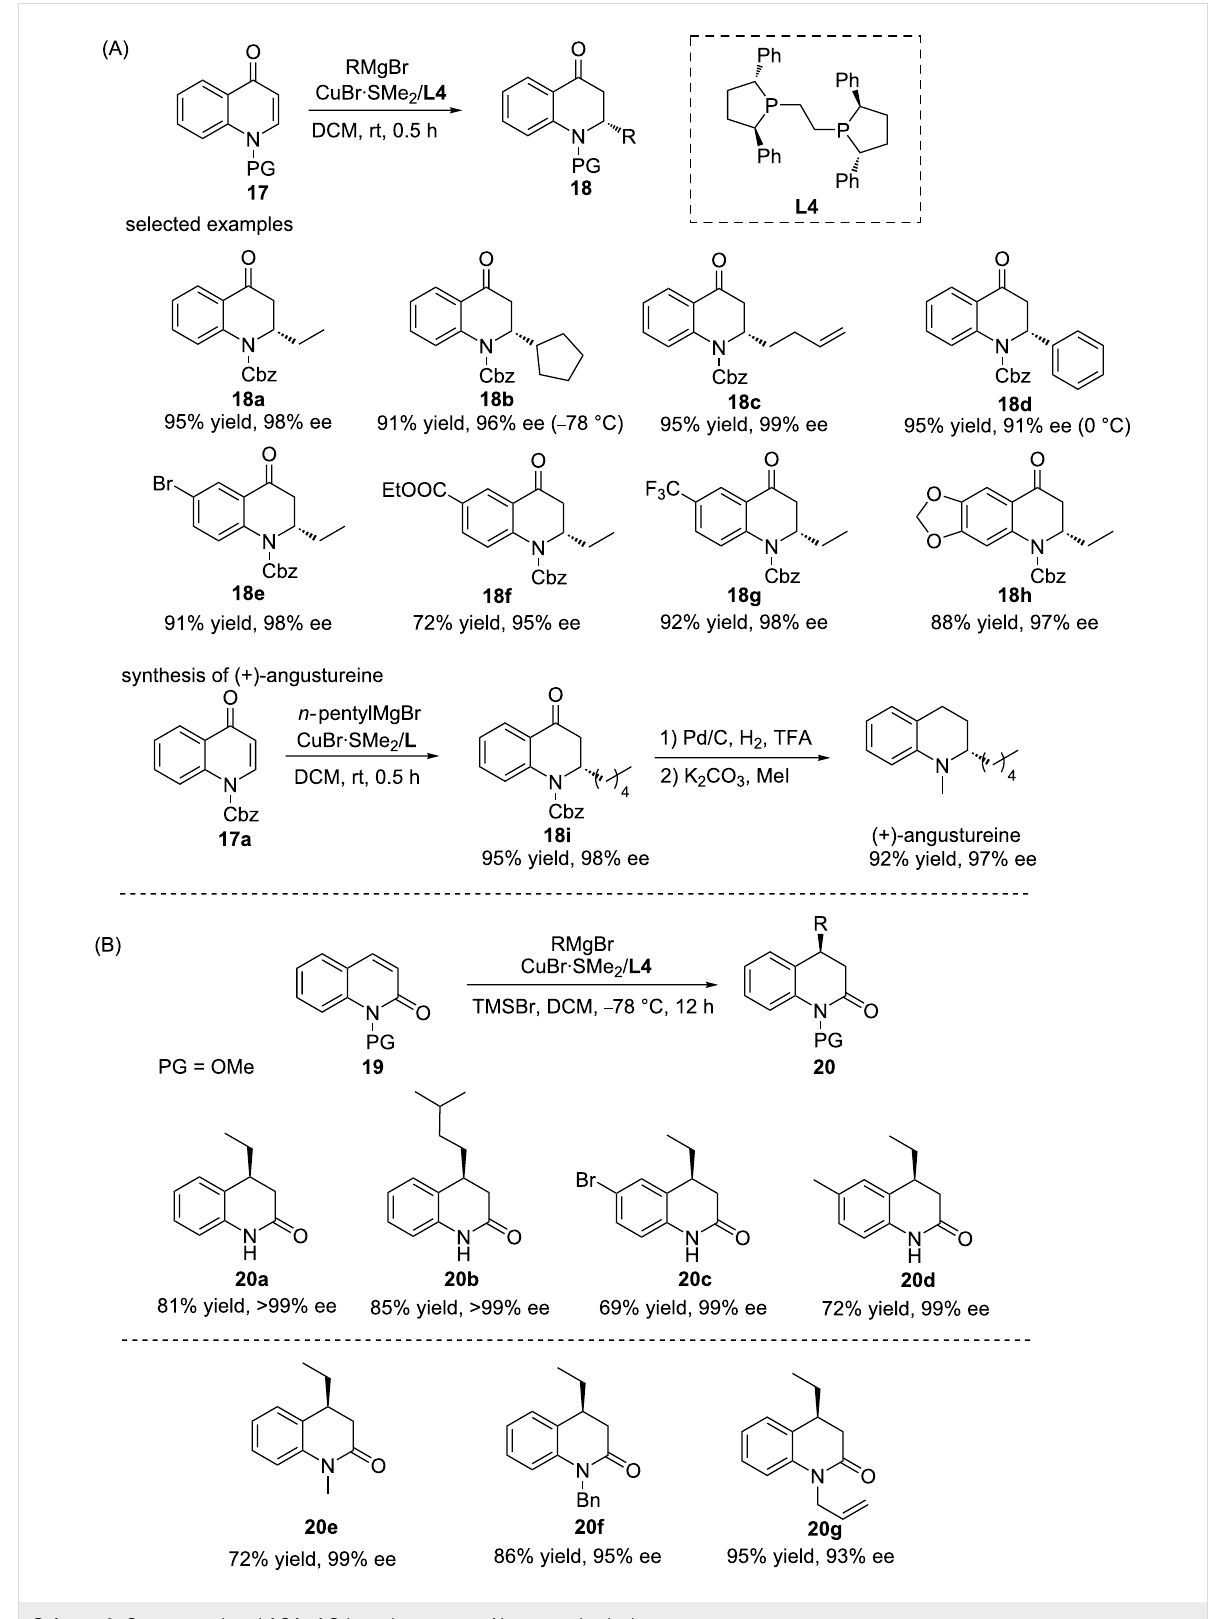
Scheme 6: Copper-catalysed ACA of Grignard reagents to N-protected